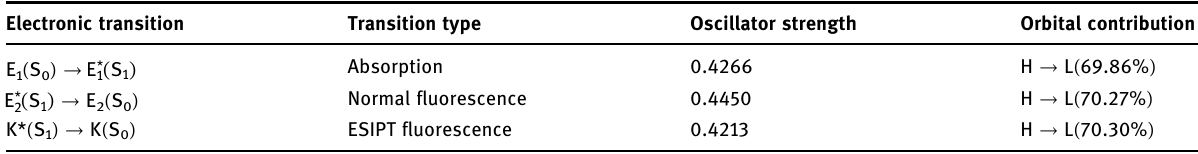
Table 5: The oscillator strengths and the orbital transition contributions of electronic transitions in the cyclohexane solvation Electronic transition